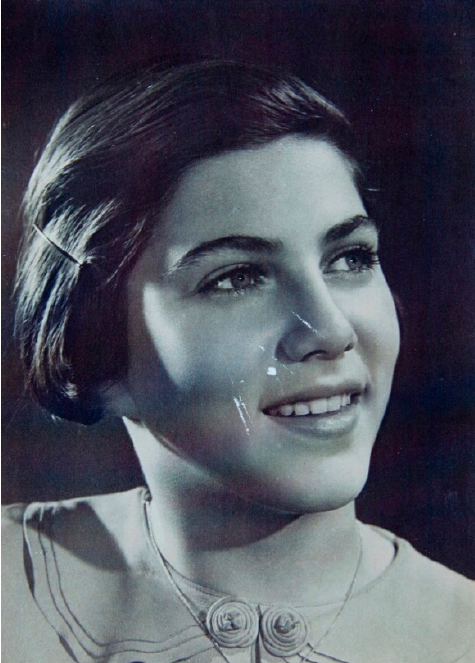
Figure 5. Unknown. Photograph Stefanie Ries . 1937. Photograph. Author’s Archives.